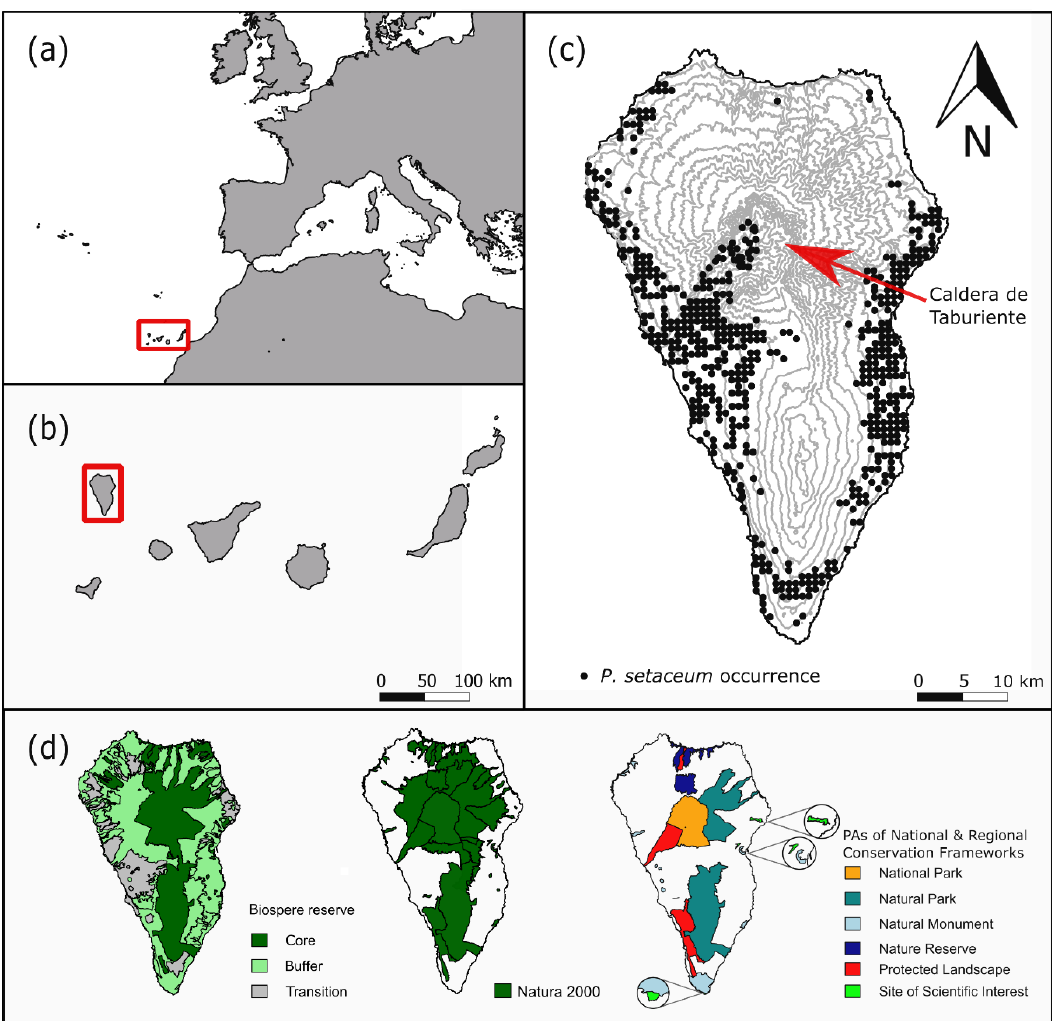
Figure 1. Location of the Canary Islands ( a ) and the position of La Palma within the archipelago ( b ). Distribution of Pennisetum setaceum occurrence points after correction for autocorrelation ( n thinned = 561) that was used for species distribution modeling ( c ). Biosphere reserve (left, d ), Natura2000 sites (middle, d ), and nationally and regionally designated protected areas (right, d ).